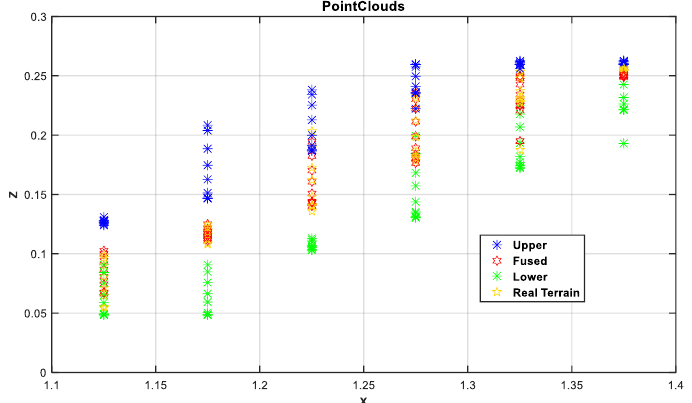
Figure 15. Terrain estimation profile results.